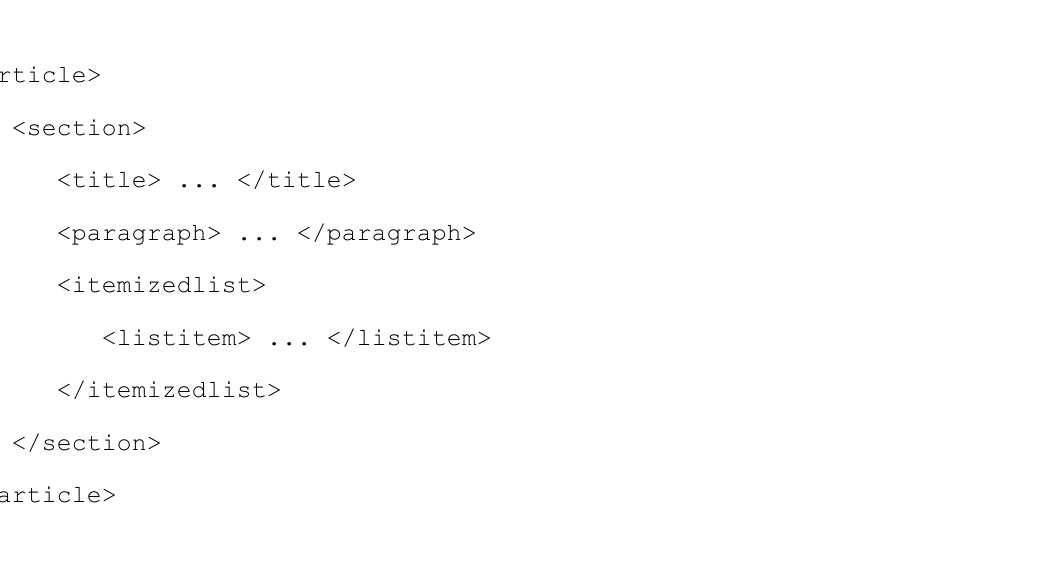
Figure 3. An example of an XML schema used to annotate text (Witt et al. , 2005: